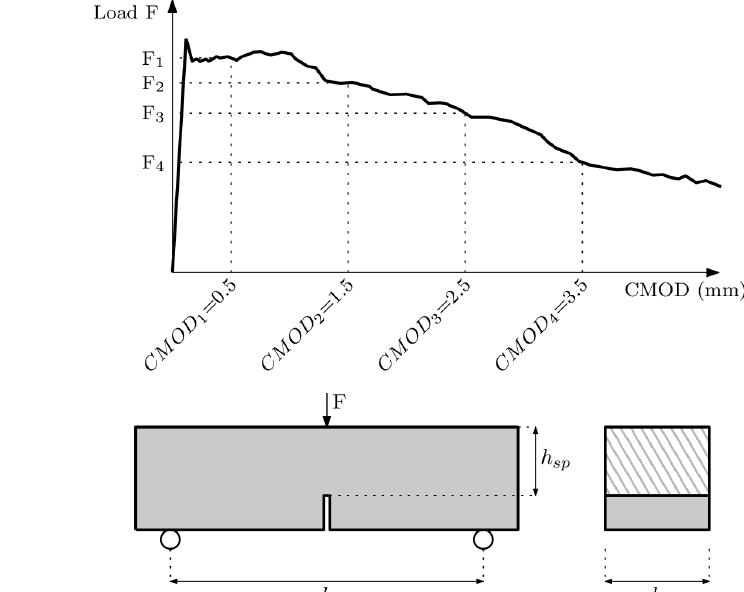
Figure 2. ( a ) Typical load F-CMOD curve for FRC and ( b ) geometry of a three-point bending test specimen.